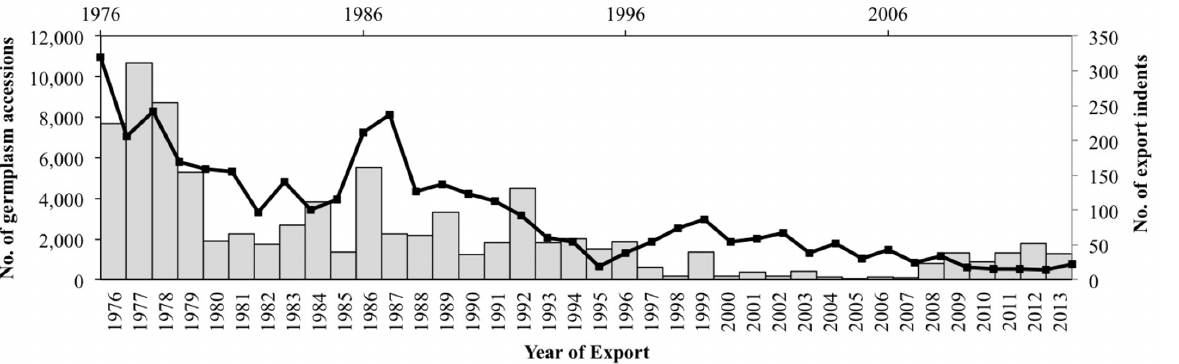
Fig 2. Year-wise export profile of Indian-origin germplasm from India to other countries. The bar graph data represents a total of 91, 403 accessions exported by India. The superimposed line graph represents the number of export indents received by India.